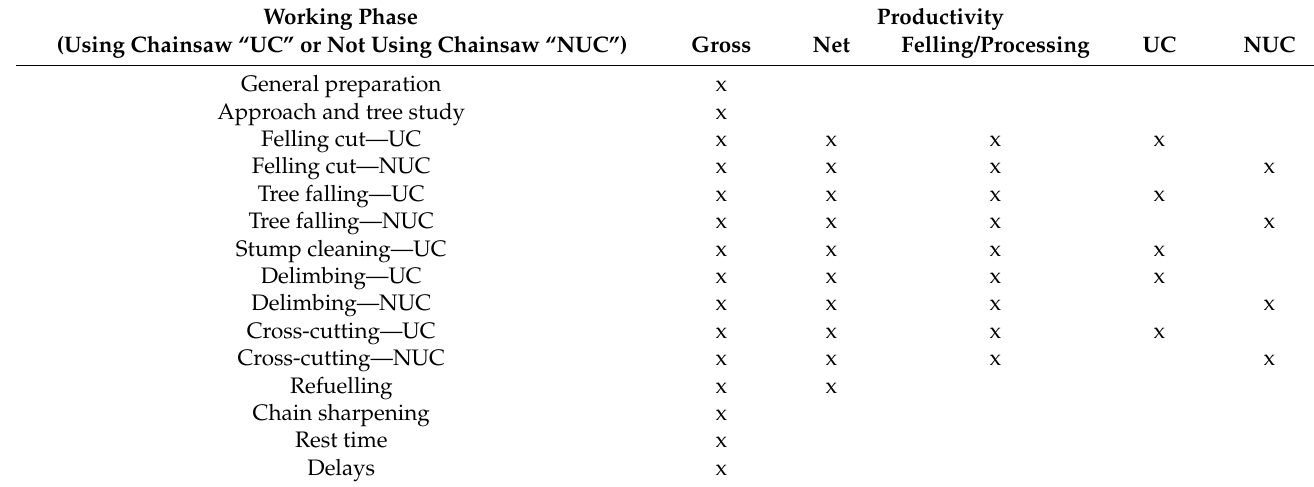
Table 2. Working phases and productivities investigated, showing where each working phase is included or